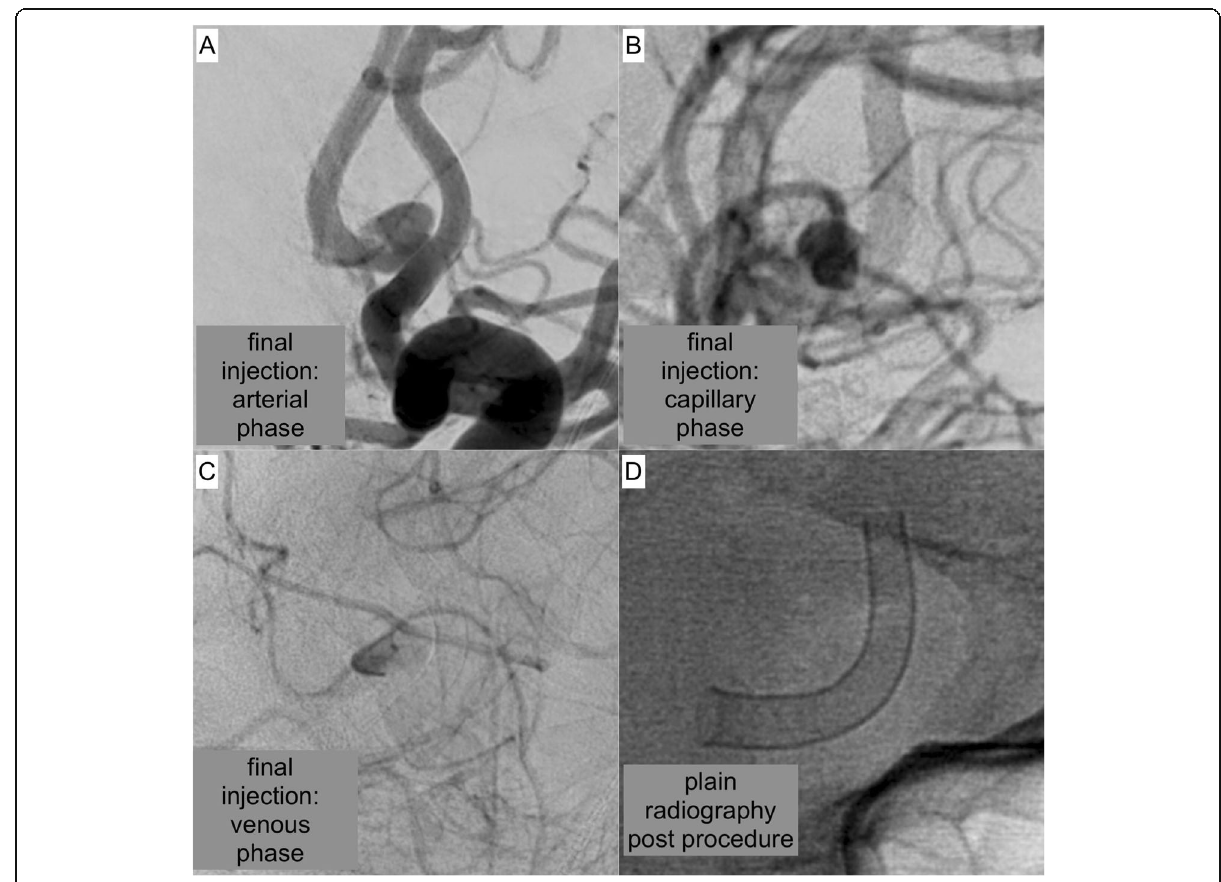
Fig. 4 illustrates the result after FDS implantation . a DSA image in working projection – arterial phase: the implanted FDS shows ideal wall apposition and optimal coverage of the aneurysm neck. b DSA image – capillary phase: extended, strong opacification of the aneurysm. c DSA image – venous phase: still persisting filling of the aneurysm sac with contrast agent, indicating high efficacy of the implanted device d Plain radiography of the implanted FDS, demonstrating complete and homogeneous unfolding of the